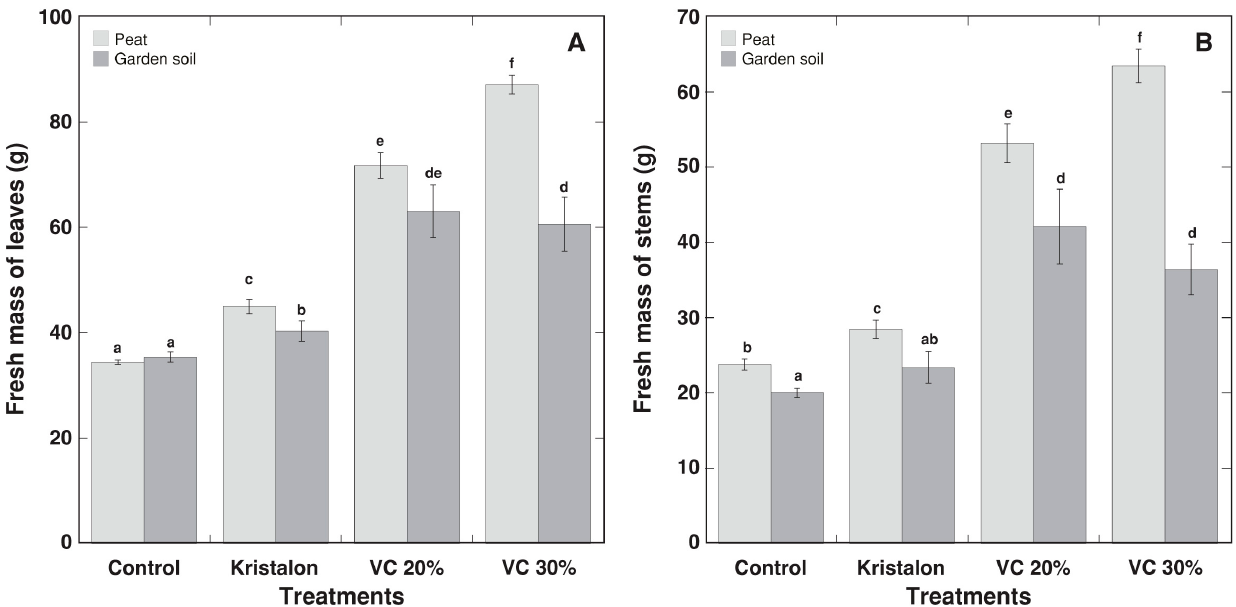
Figure 4. Effect of mineral fertilizer (Kristalon) and amendment with vermicompost (VC) at a 20% and 30% ( v/v ) rate on fresh mass of leaves ( A ) and stems with inflorescences ( B ) of Dracocephalum moldavica plants grown in peat substrate or commercial garden soil for 8 weeks. Results are means ± SE from five replicates for each treatment. Means with identical letters are not considered statistically significantly different ( p < 0.05).